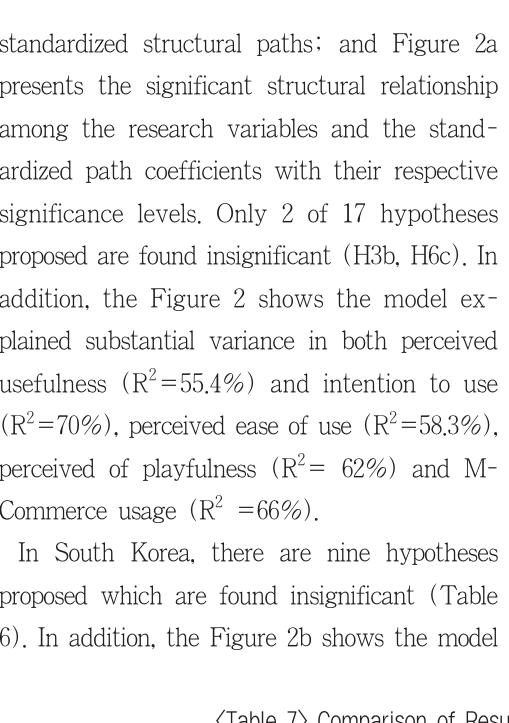
<Table 7> Comparison of Results: Viet Nam versus South